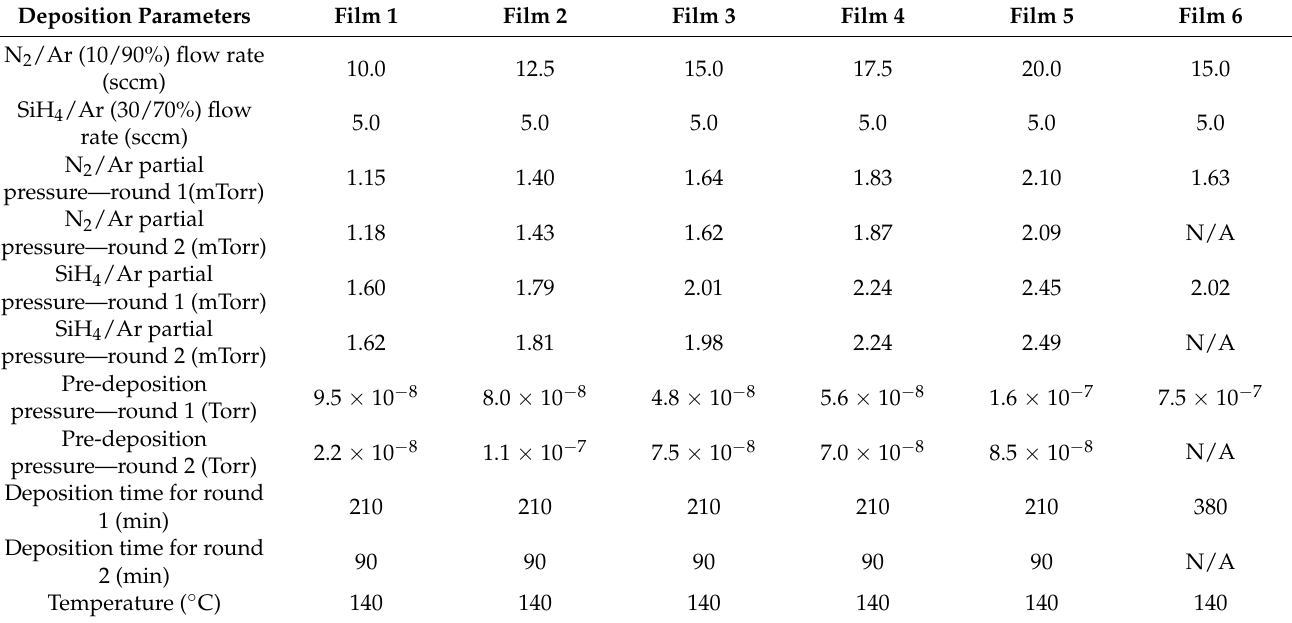
Table 1. SiO x N y :H z thin-film deposition